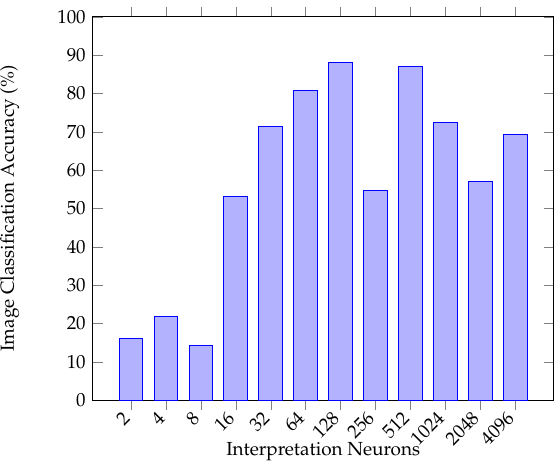
Figure 10. Mean image 10-fold classification accuracy corresponding to interpretation neuron